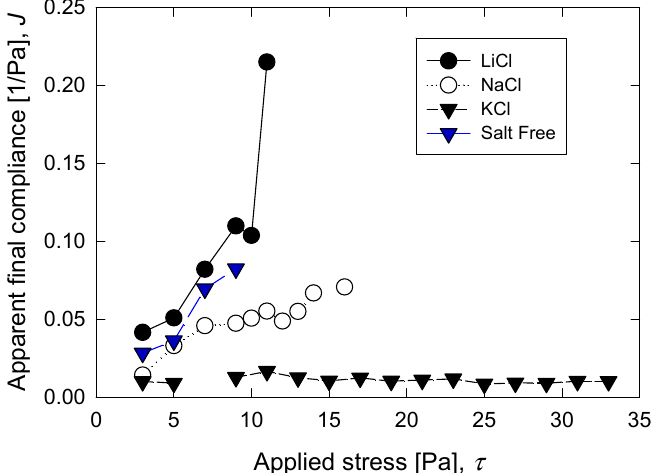
Figure 3. Apparent final compliance of silica suspensions after creep tests of 600 s as function of applied load τ and different salts (0.5 M).